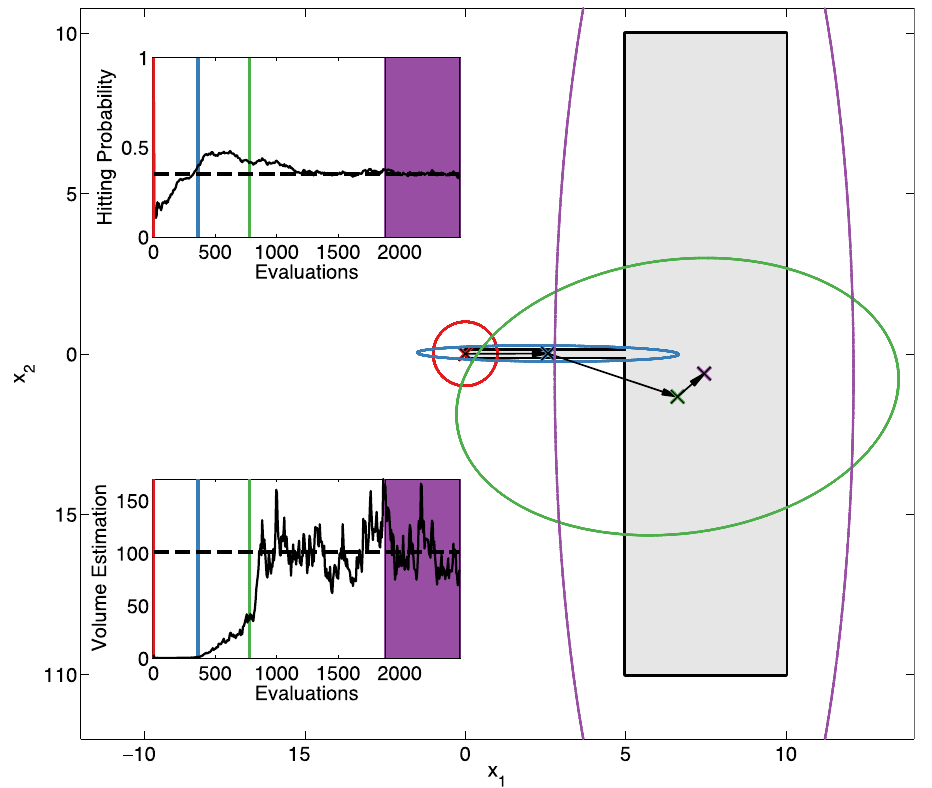
Figure 3. Illustration of L p -Adaptation using the test case of Storn 15 . The feasible region (shaded gray) is non- convex and deceiving, consisting of a large rectangle with a thin arm attached to it. The algorithm is started from the tip of the arm, which is an unfavorable starting point (red). Even though it initially cannot “see” the large rectangle, the proposal distribution adapts to the shape of the arm (blue) within 355 evaluations and discovers the large rectangle after 775 evaluations (green). The evolution of the design center is shown by crosses, the L 2 proposal is shown as ellipses. Colors correspond to the evaluations as indicated. The two inset plots show the evolution of the hitting probability and the volume estimate versus the number of function evaluations. The final design center and volume (purple) are obtained by averaging over the last 600